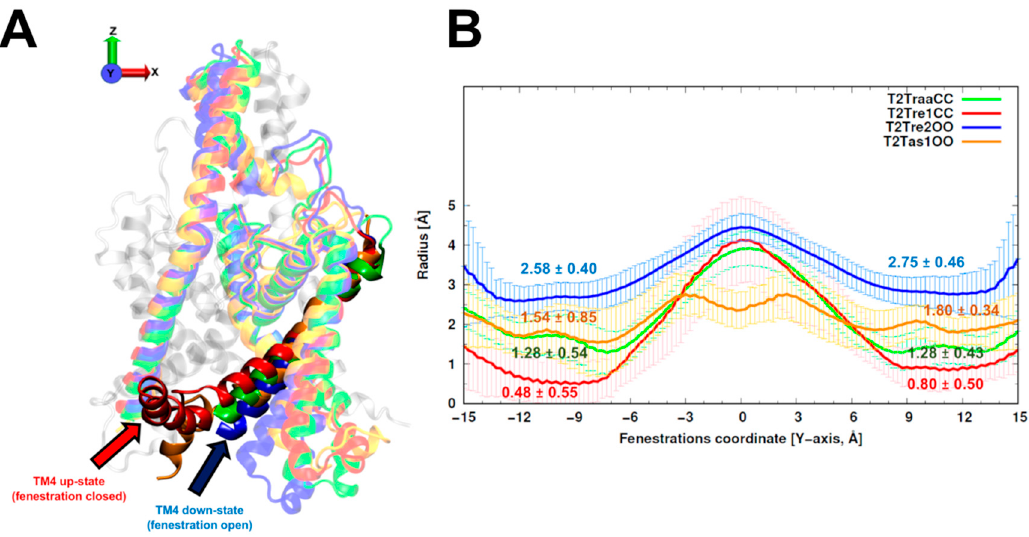
Figure 1. Comparison of the fenestration dimensions between TASK-2 homology models. ( A ) Structural alignment of the best T2Tre2OO model (blue), T2Tre1CC model (red), T2TaskCC model (yellow), and T2TraaCC model (green). The TM4 helix of one monomer is shown by an arrow indicating the up- or down-state; ( B ) The average radius of each fenestration ( ± standard deviation) from 150 homology models of the TASK-2 channel calculated with the HOLE program [26]. The fenestrations are disposed in the X -axis [ − 15, − 6] Å and [6, 15] Å, while the central cavity is located at [ − 5, 5] Å approximately. The numbers over each plot represents the bottleneck radius in each fenestration.